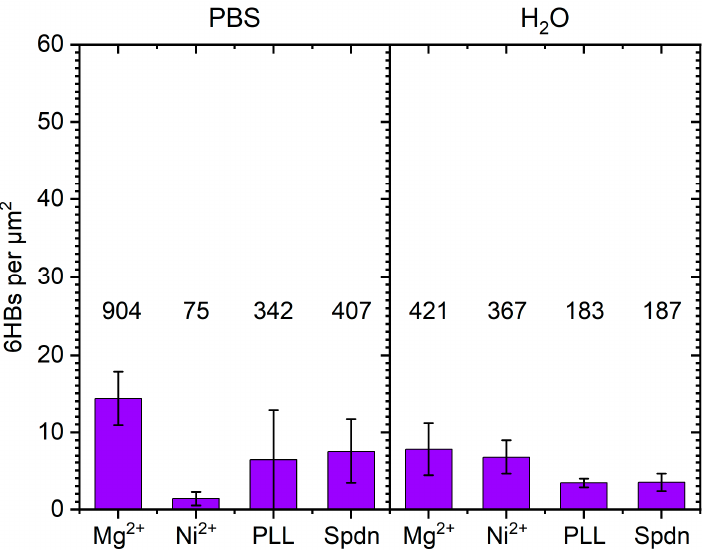
Figure 9. Surface coverage of adsorbed 6HBs obtained for the different surface pretreatments and solution conditions. Values represent averages of six AFM images with the standard deviations as error bars. The total number of counted 6HBs used in the statistical analysis is given above each bar.